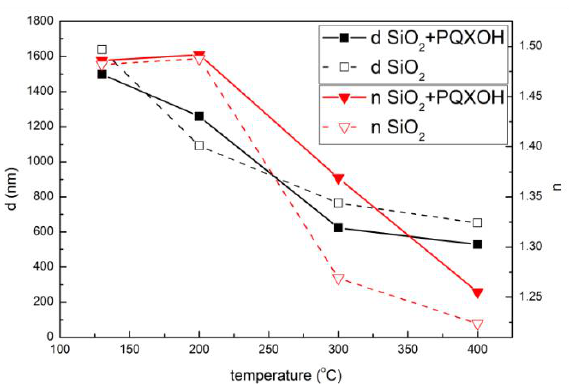
Figure 7. Change in the thickness and refractive index of the silica films and PQXOH doped silica films depending on the annealing temperature of the produced layers on soda-lime glass substrates (130, 200, 300, 400 °C). The solid lines were drawn to guide the eye .